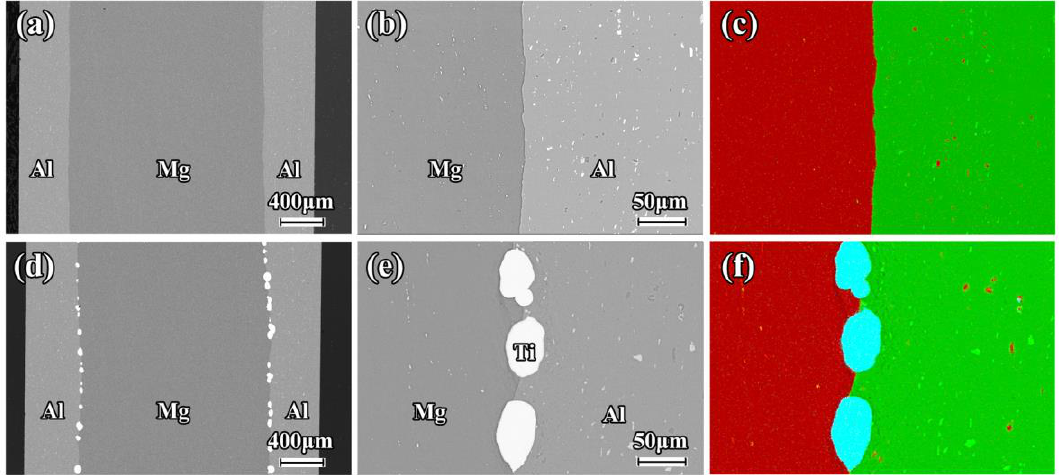
Figure 2. Low magnification and high magnification cross - sectional SEM micrographs of composite sheet: ( a – c ) Mg/Al, and ( d – f ) Mg/Al - Ti. EDS mapping showing the element distribution of Al (green points), Mg (red points), and Ti (blue points).